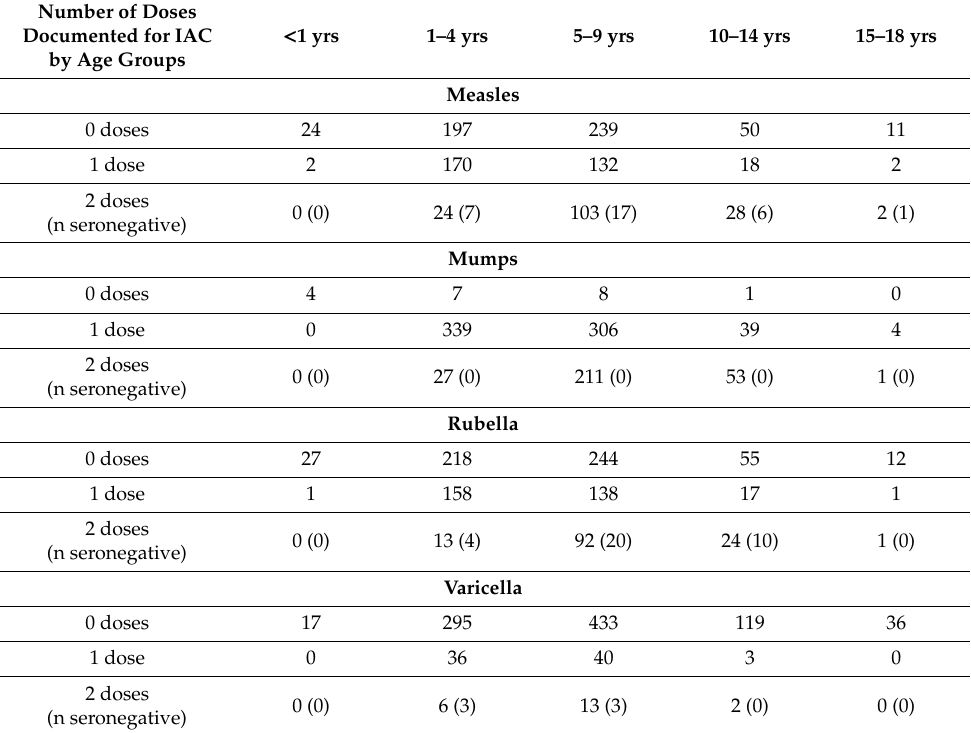
Table 5. Documentation of vaccination for the IAC enrolled from the Meyer Children’s University Hospital and referred to a hypothetical population of 1000 IAC.